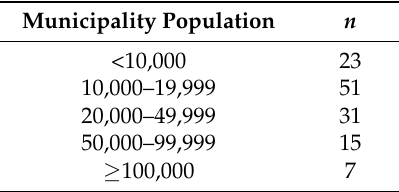
Table 4. Size of